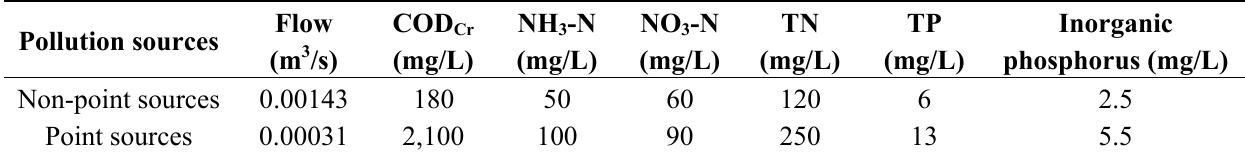
Table 6. Flow and concentration of pollution sources.